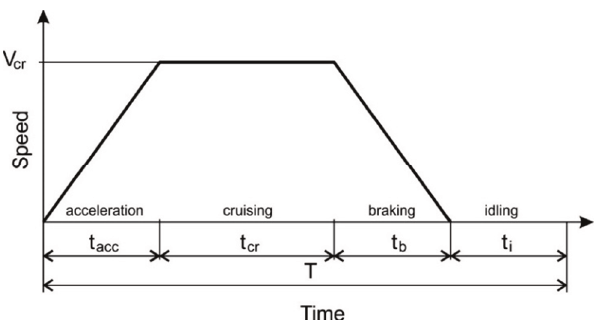
Fig. 3. The speed pattern used for evaluation of the share of the regenera- tive braking specific energy